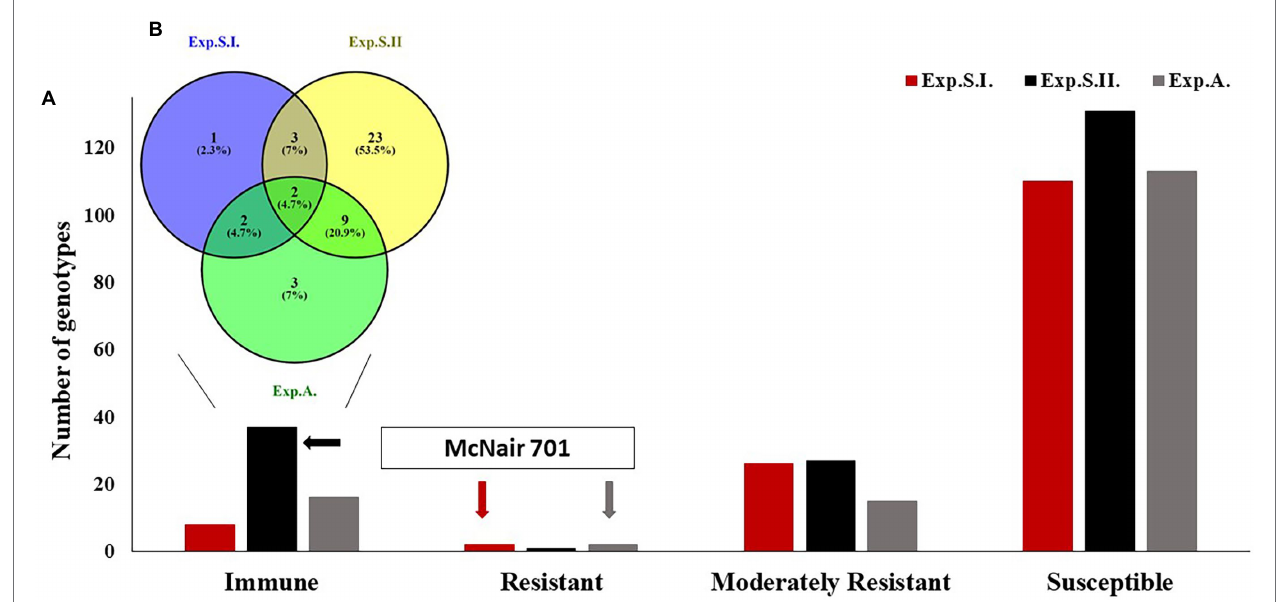
FIGURE 1 | The response of the tested wheat diverse panel to the different leaf races in Exp.S.I., Exp.S.II., and Exp.A. (A) The number of immune, resistant, moderately resistant, and susceptible genotypes in each experiment. (B) Number of common immune genotypes among the experiments.